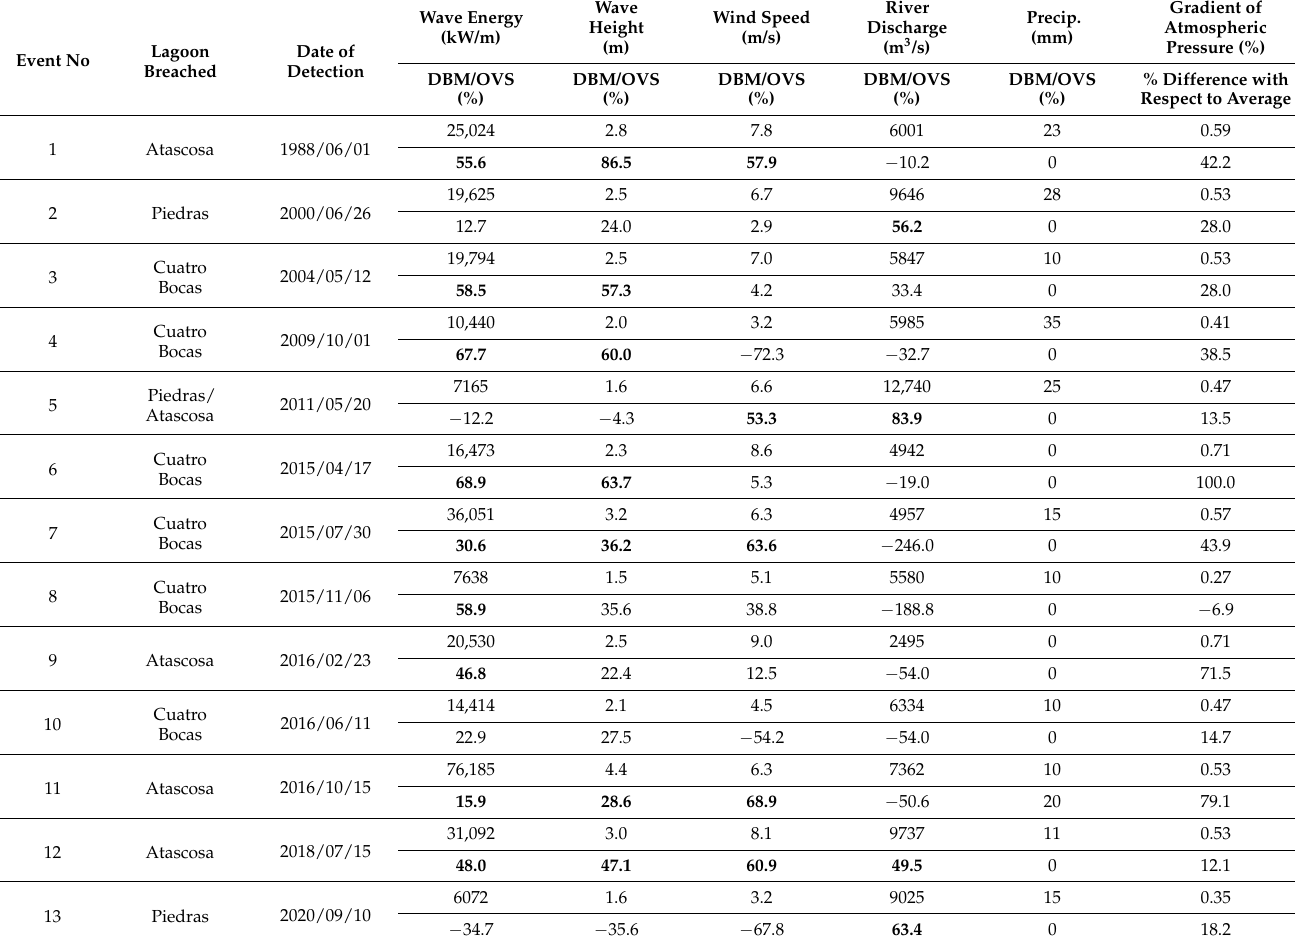
Table 1. First appearance of lagoon breachings detected for the period 1973–2020. Maximum daily value and DBM/OVS expressed in percent in the three weeks prior to the first appearance for hydro- climatic variables. Note: Bold fonts indicate the variable(s) that likely caused the breaching event.